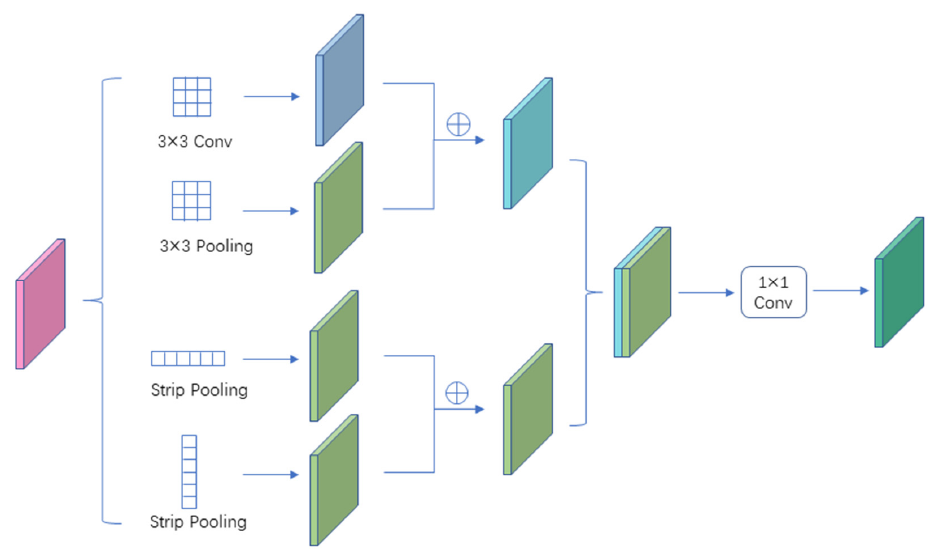
Figure 4. Illustration of feature enhancement module.